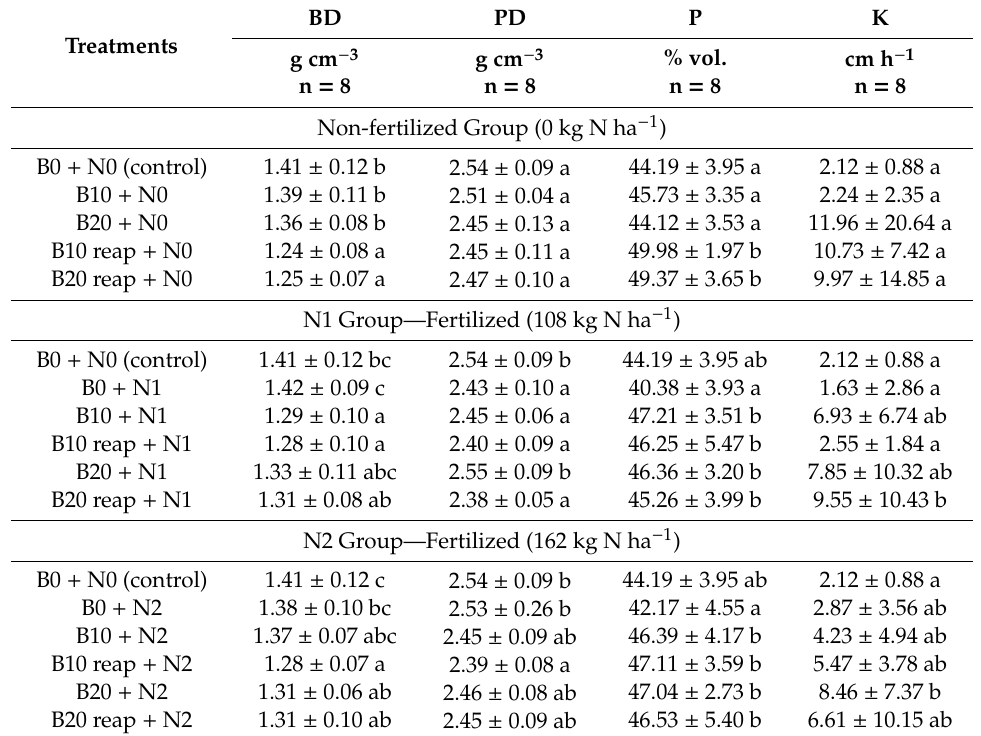
Table 5. E ff ect of biochar application and re-application on bulk density, particle density, porosity, and saturated hydraulic conductivity (means ± standard deviations). Di ff erent letters indicate that treatment means are significantly di ff erent at p < 0.05 according to least significance di ff erence test.